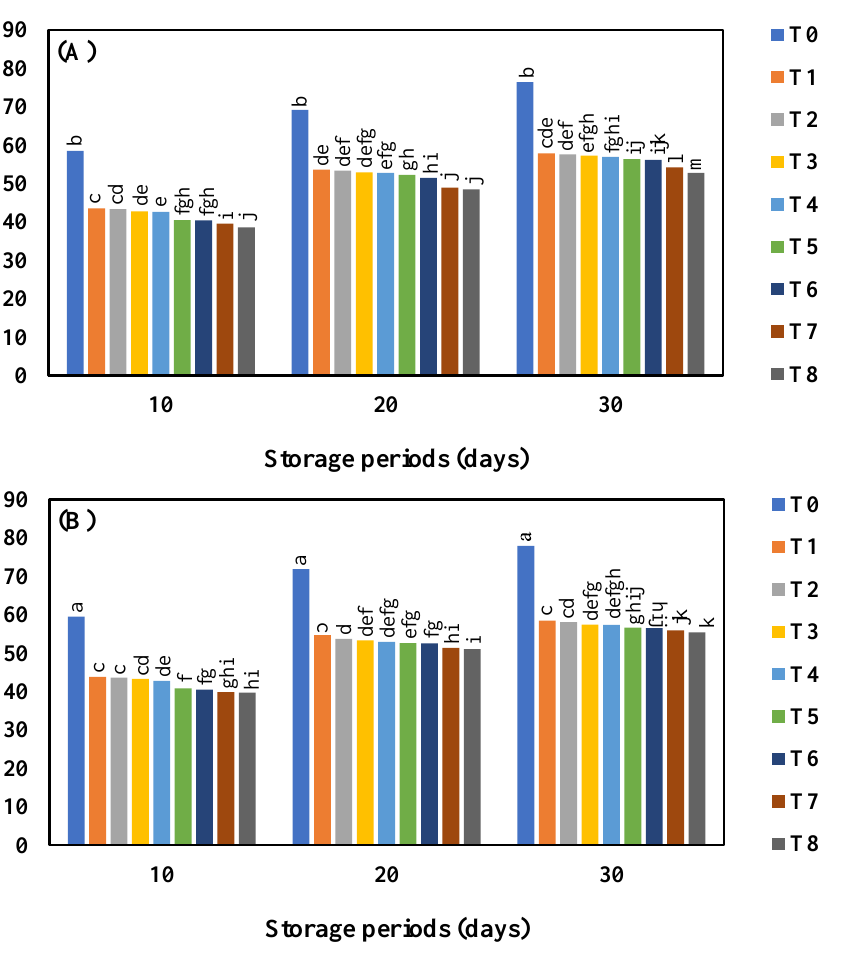
Figure 5. Effect of AgNO 3 and Ag-NPs on malondialdehyde (MDA) content in Shine Muscat ( A ) and Kyoho ( B ) grape varieties during 30 days cold storage.